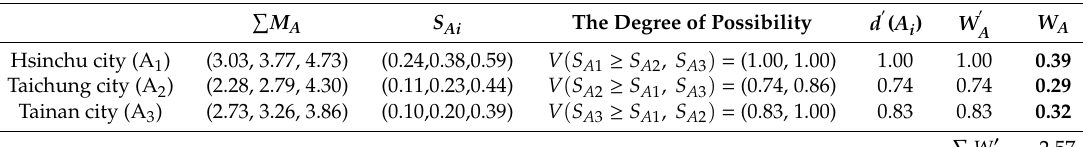
Table 8. The weight vector of A 1 –A 3 with respect to C